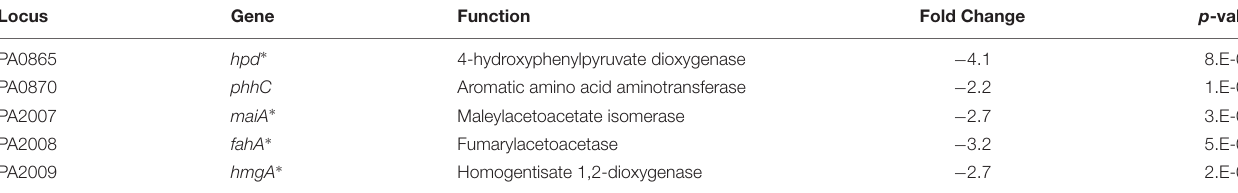
TABLE 2B | Down-regulated genes involved in aromatic amino acid catabolism. Locus Gene Function